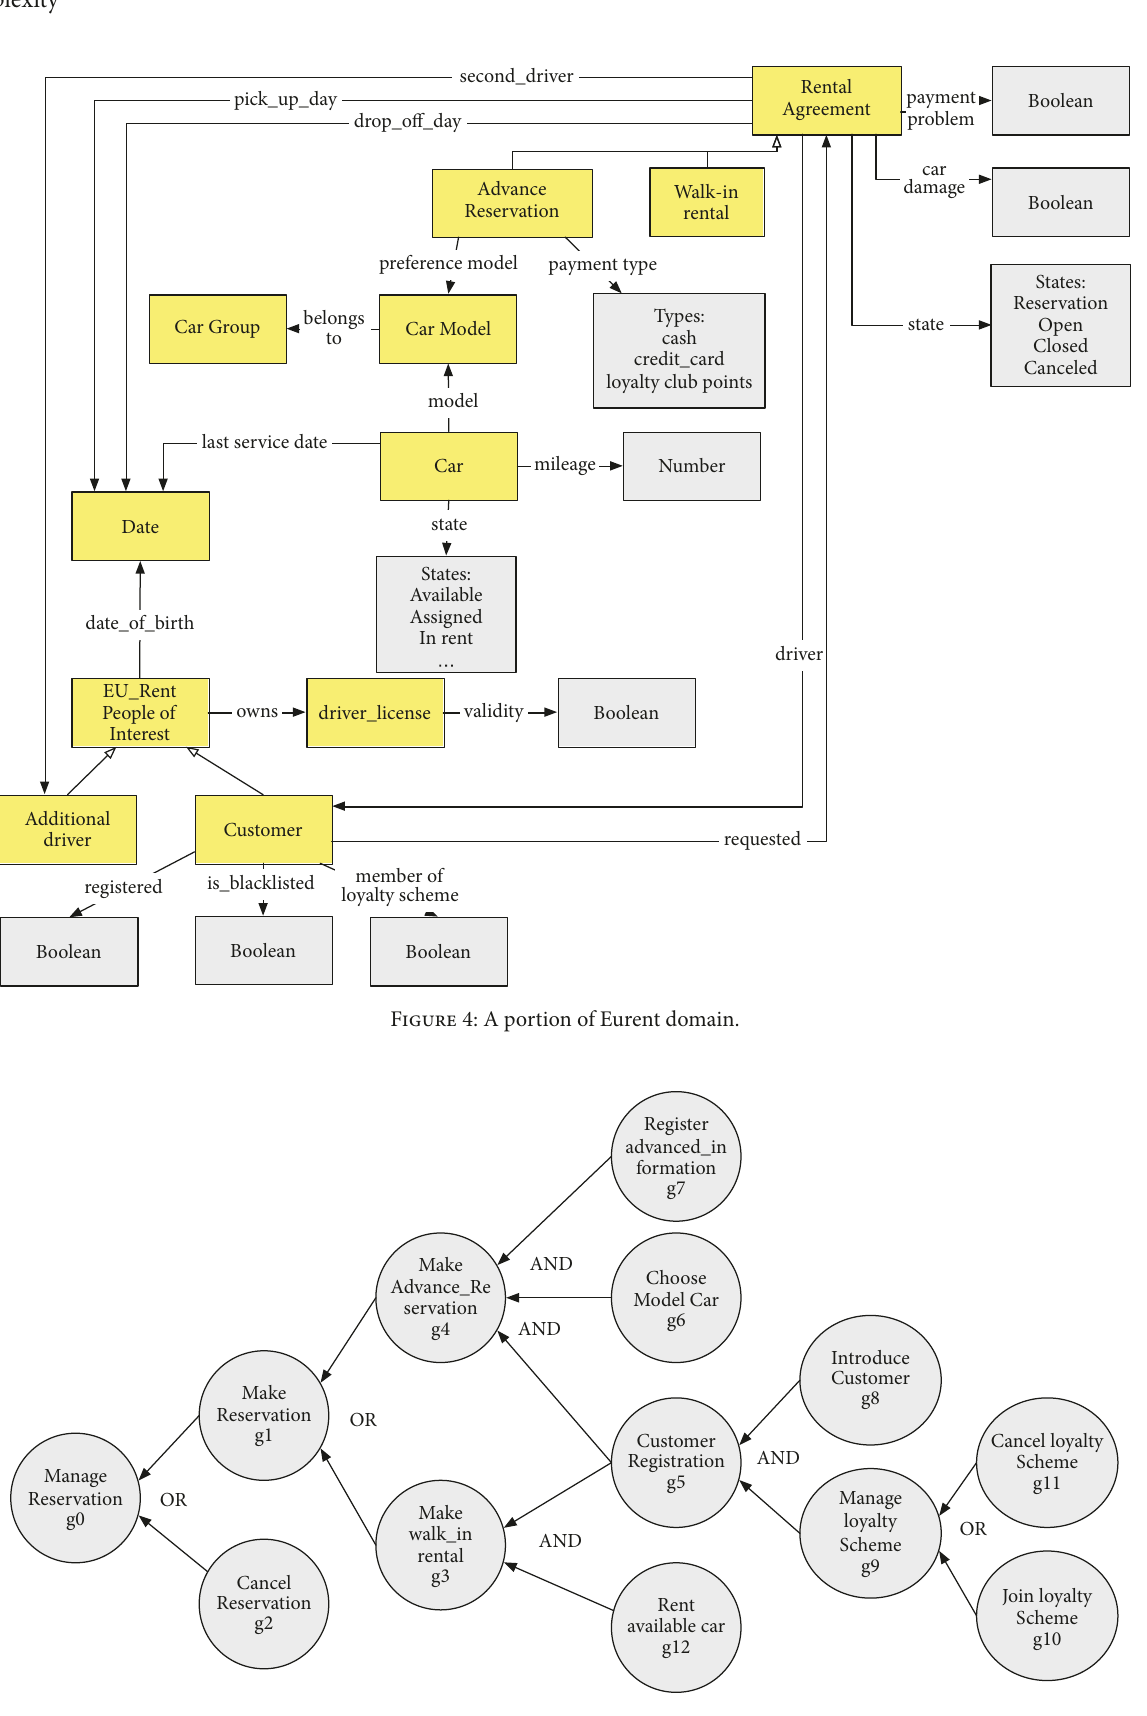
Figure 5: A portion of Eurent goal